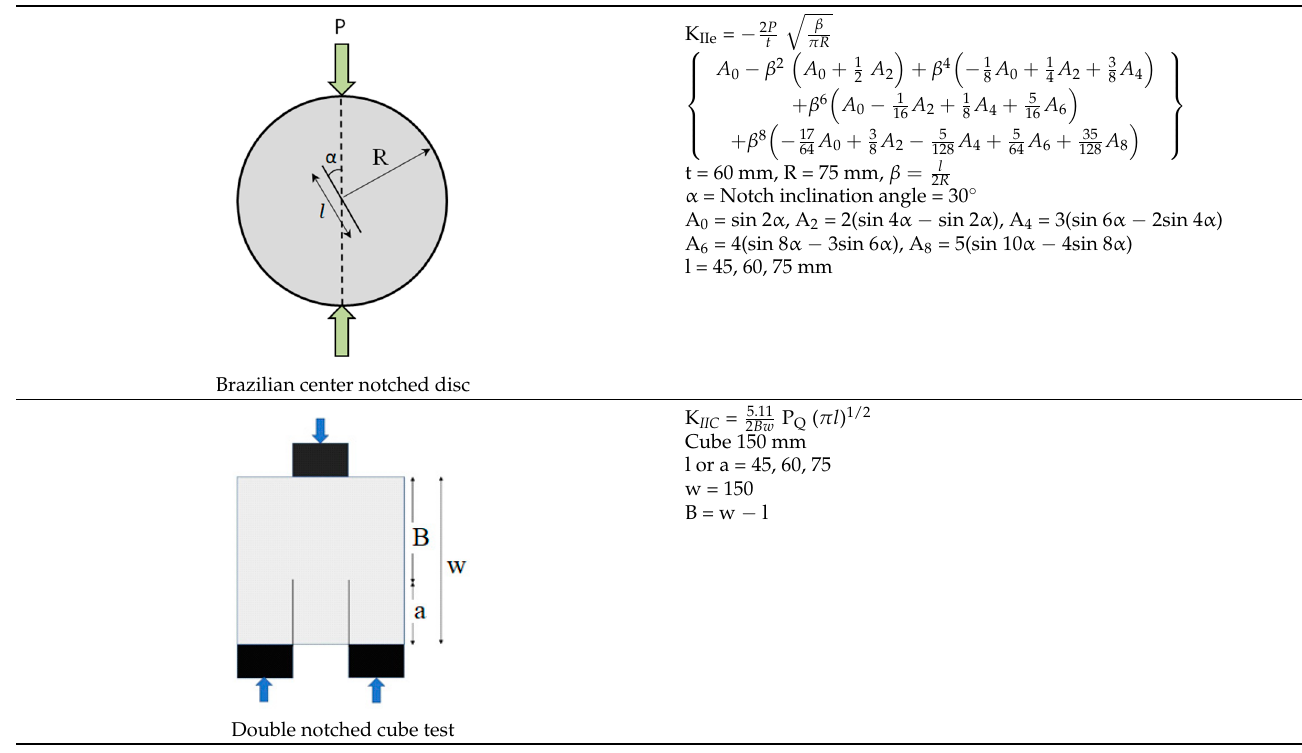
Table 3. Mode II fracture toughness test geometries.